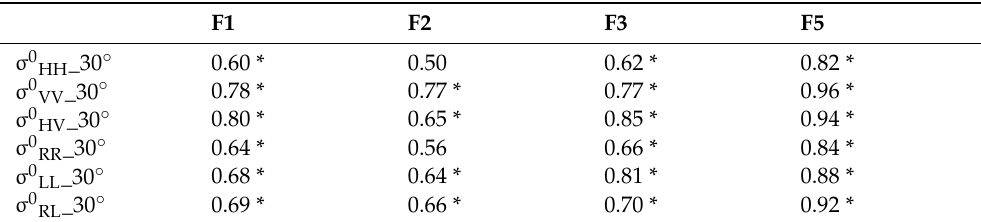
Table 7. Correlation coefficients of σ 0 vs. soil moisture at L-band ( θ = 30 ◦ ) for F1, F2, F3, and F5 sites. significant correlations ( p -value < 0.05) are denoted with ‘*’.